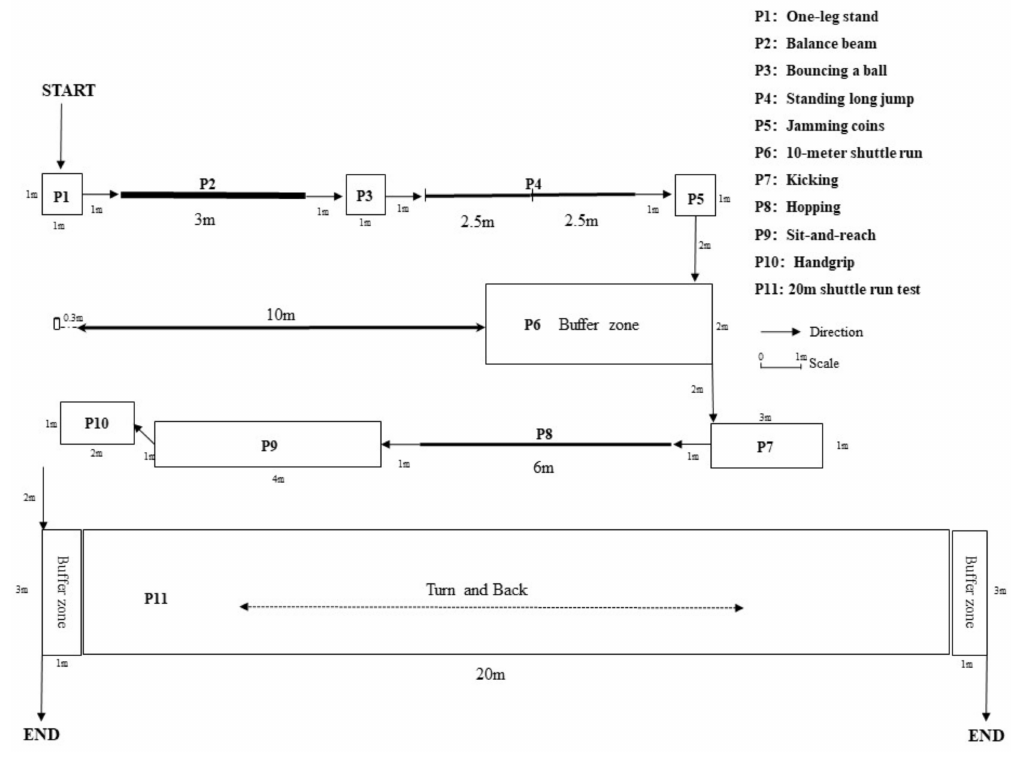
Figure 2. Flow of the assessments of measures in the